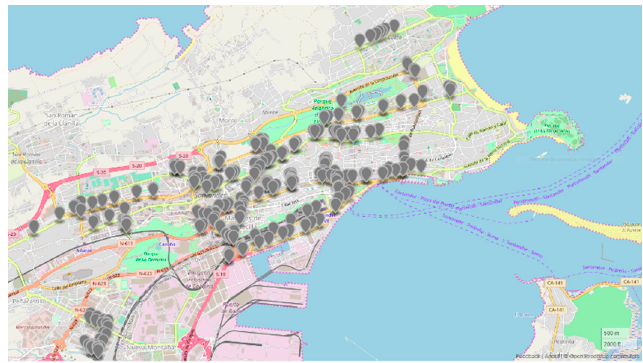
Figure 6. Map of magnetic loops location in the city of Santander.